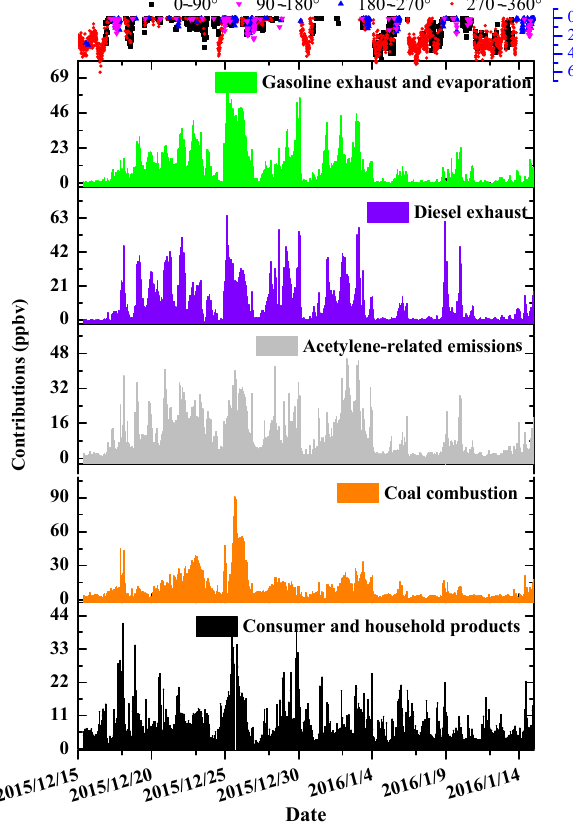
Figure 7. Time series of the contributions from gasoline-related emissions, diesel exhaust, coal combustion, acetylene-related emis- sions, and consumer and household products to atmospheric